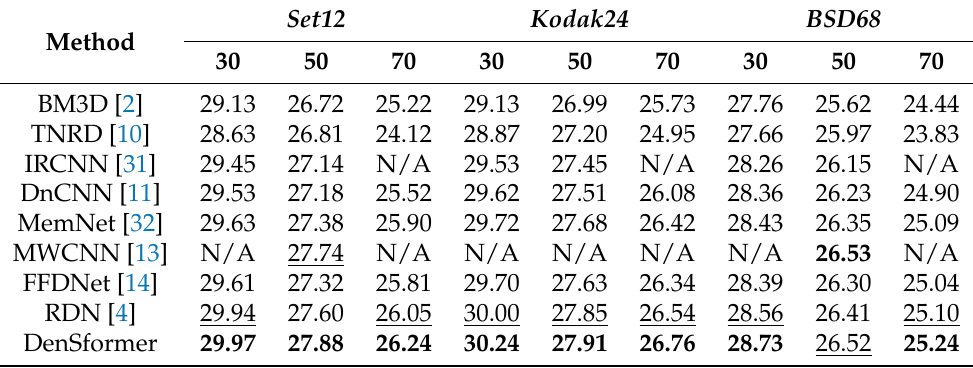
Table 1. Quantitative results about non-blind gray-scale image denoising (PSNR